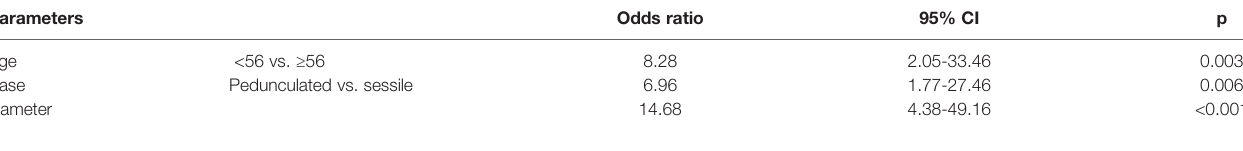
TABLE 2 | Multivariate analysis of risk factors related with malignant